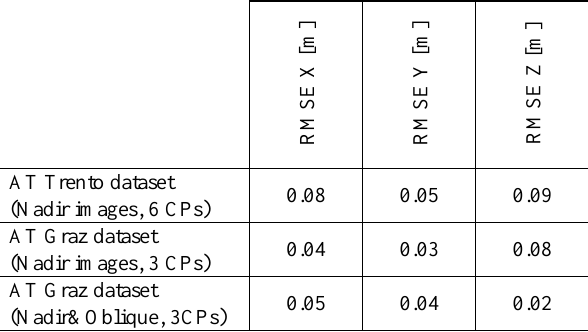
Table 2. Results of aerial triangulation for the Trento and Graz datasets.